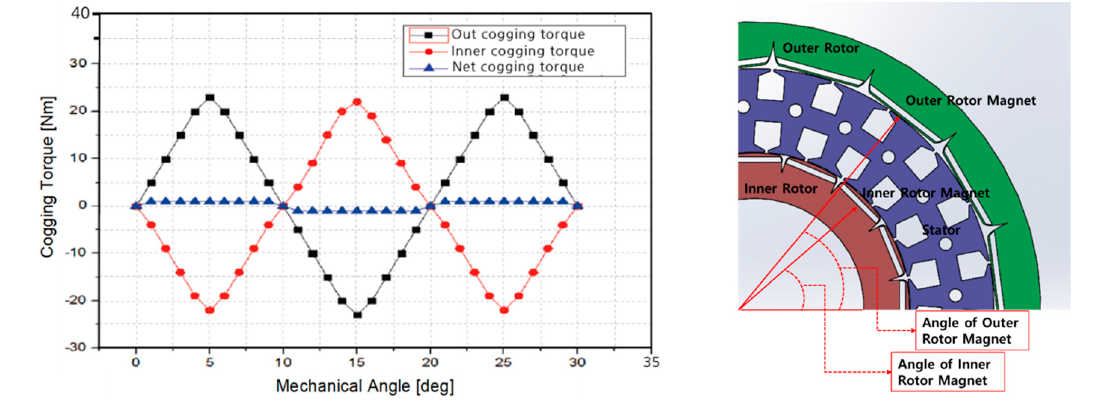
Figure 10. Cogging torque when the magnet angle is 5.62°.